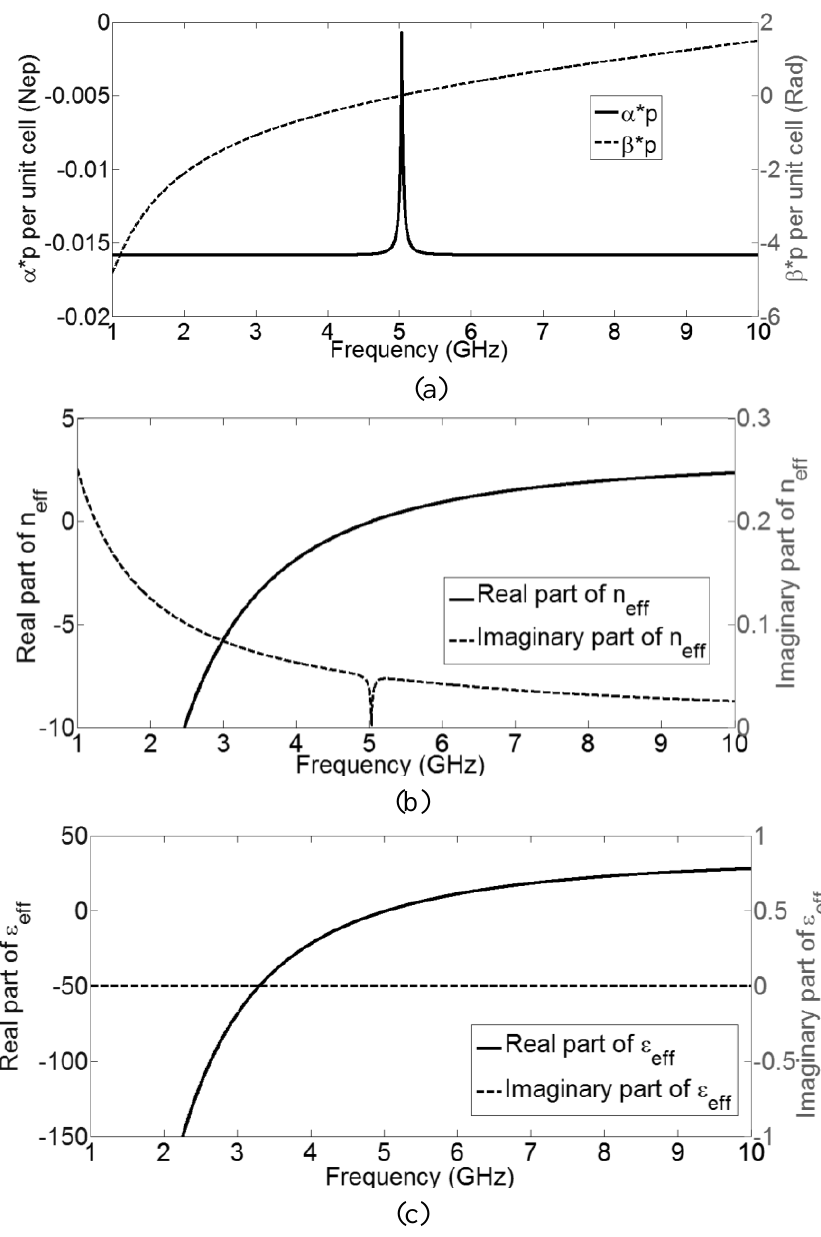
( a ) Attenuation constant  (solid line) and phase constant  (dotted line); ( b ) Real and imaginary part of the effective index of refraction n (assuming a realistic unit cell eff physical length of 3 mm); ( c ) Real and imaginary part of the effective permittivity  eff (assuming a realistic unit cell physical length of 3 mm); ( d ) Real and imaginary part of the effective permeability µ (assuming a realistic unit cell physical length of 3 eff